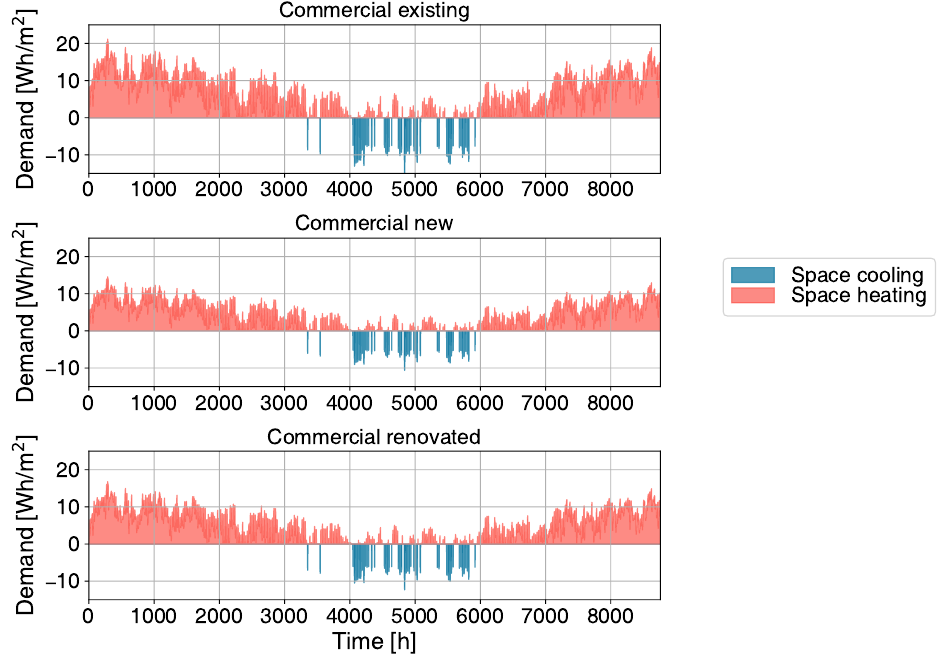
Figure A3. Hourly specific energy service demand of residential MFH buildings.